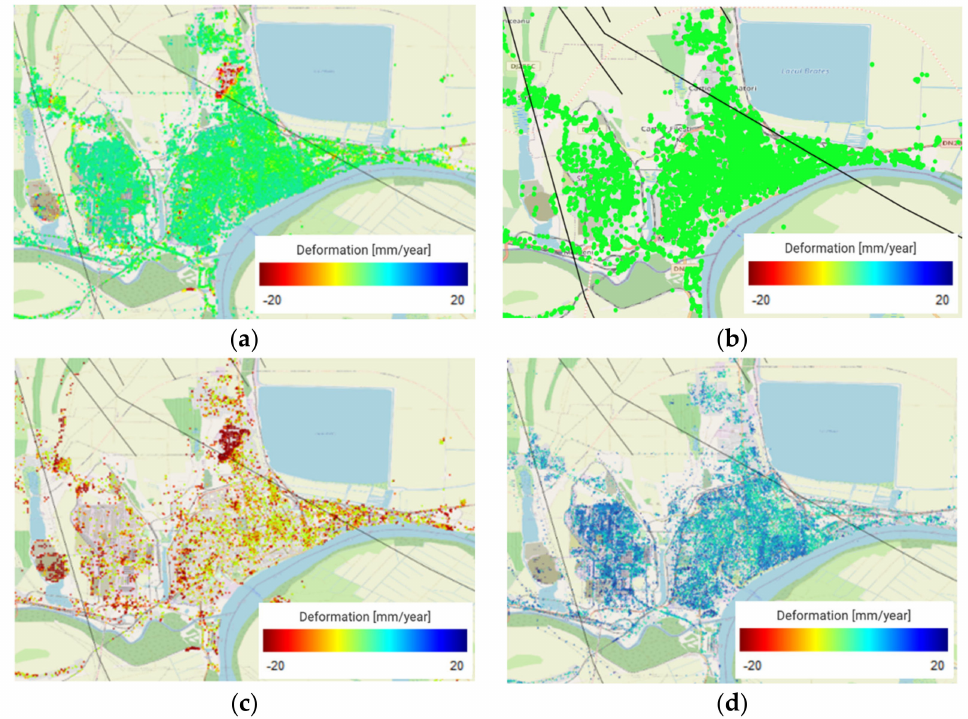
Figure 18. Total ground motion and separation in three components (stable, up and down): ( a ) total ground motion; ( b ) stable targets; ( c ) subsidence; ( d ) uplift. Black lines = local and regional fault systems (from